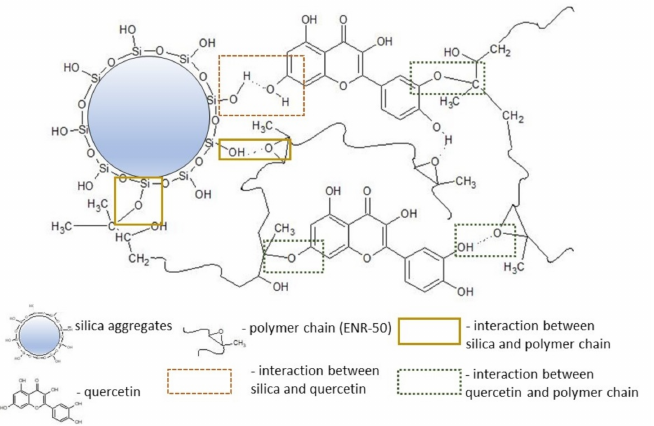
Figure 7. Proposed structure and interactions in ENR/quercetin/silica